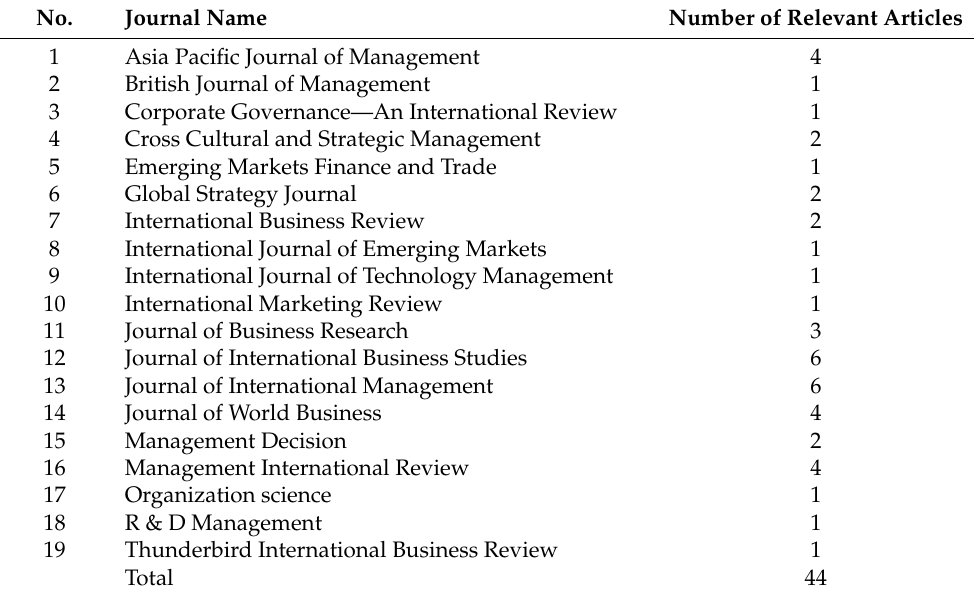
Table 1. Scholarly journals published articles on EMNE’s entry mode decision-making involving volatile environmental